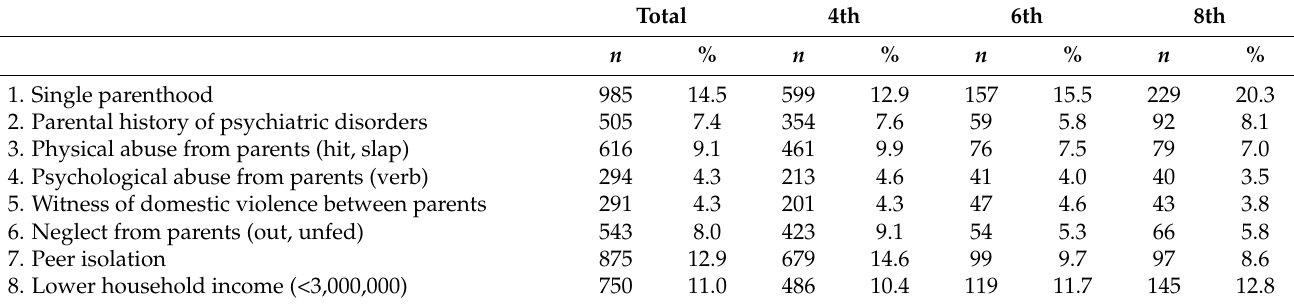
Table 2. Distribution of categories of adverse childhood experiences (ACEs).